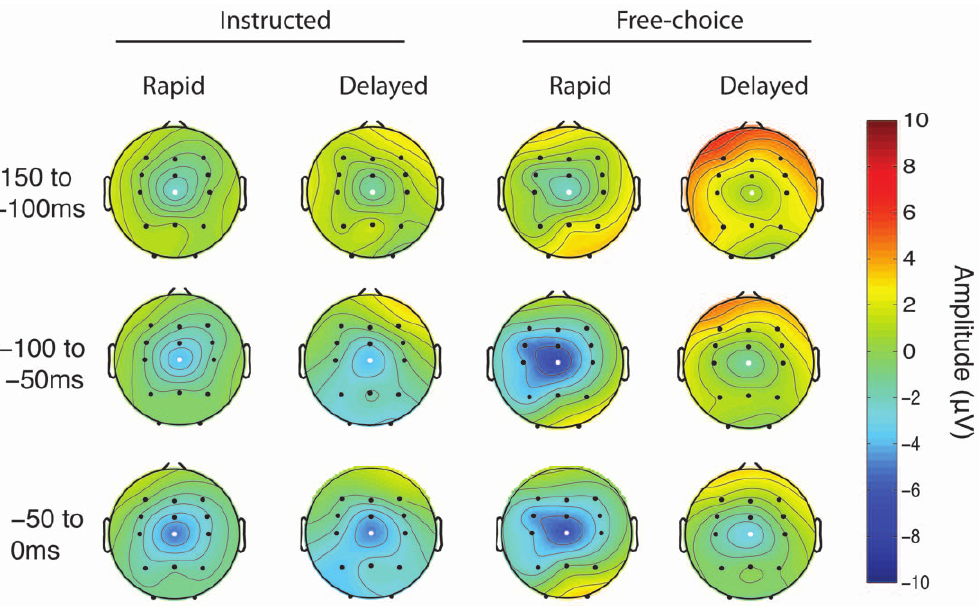
Figure 3. Topographical plot of ERP amplitude before the instruction cue. Topographical distribution of the CNV component for each of the four main conditions, averaged over three time windows selected for analysis. White highlight shows electrode Cz, from which the mean time